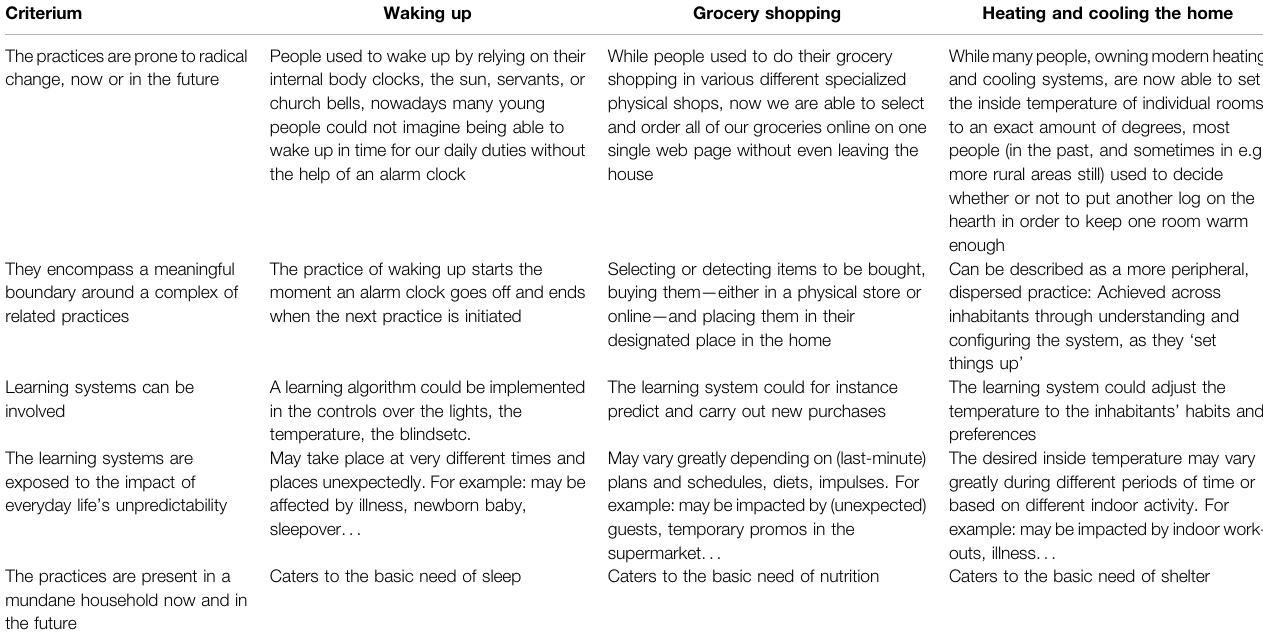
TABLE 1 | The selected social practices versus the selection criteria. Criterium Waking up Grocery shopping Heating and cooling the